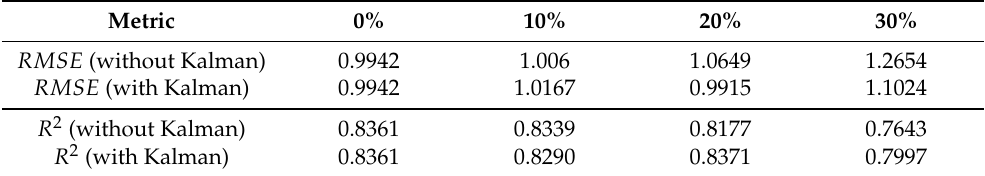
Figure 12. Operation of the recovered process after the analysis of the lost packets. Table 4. Process errors as a function of packet loss ratio.